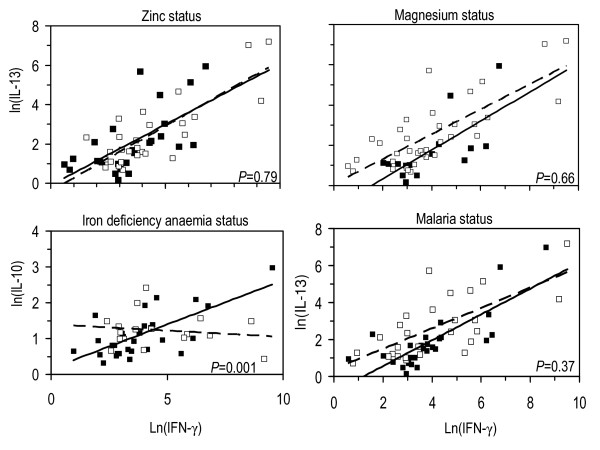
Relationships between supernatant concentrations of IFN-γ, IL-10 and IL-13 under different conditions of micronutrient and malaria status at the time of blood collection, following 7 days stimulation of PBMCs with Plasmodium falciparum-infected erythrocytes. Regression lines and dots in respective panels: closed dots and solid lines = zinc replete, magnesium replete, no iron deficiency anaemia and no malaria; open dots and dashed lines = zinc deficiency, magnesium deficiency, iron deficiency anaemia and positive malaria tests at time when blood was collected. The differences in slopes for other relationships are shown in Table 3. P-values have been calculated to indicates whether the interaction between nutrition status and malaria infection status have impact on the association between IFN-γ and IL-10.